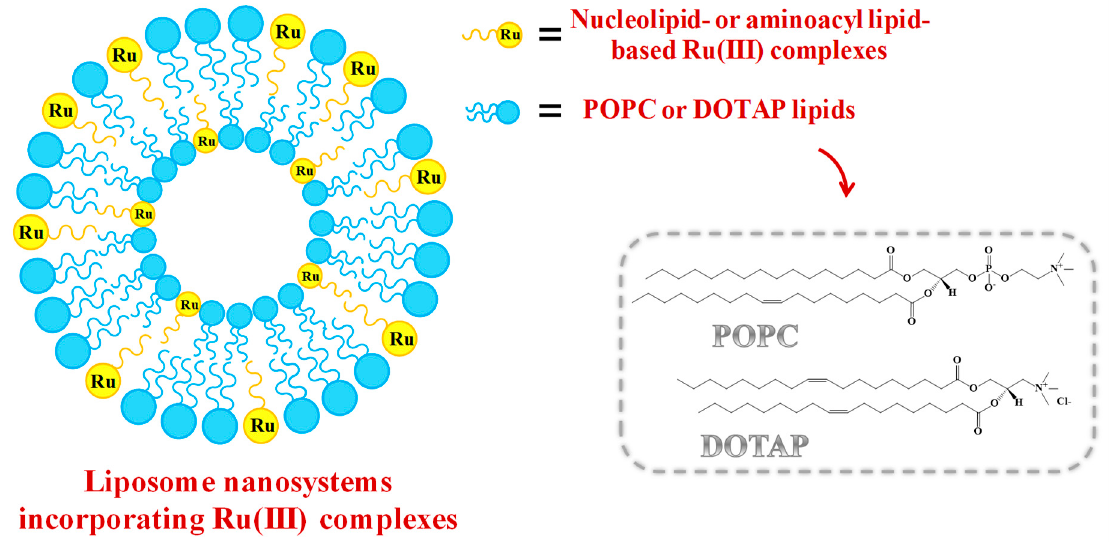
Figure 7. Schematic representation of liposomal POPC- or DOTAP-based nanoaggregates containing nucleolipid- or aminoacyl lipid-based Ru(III) complexes.